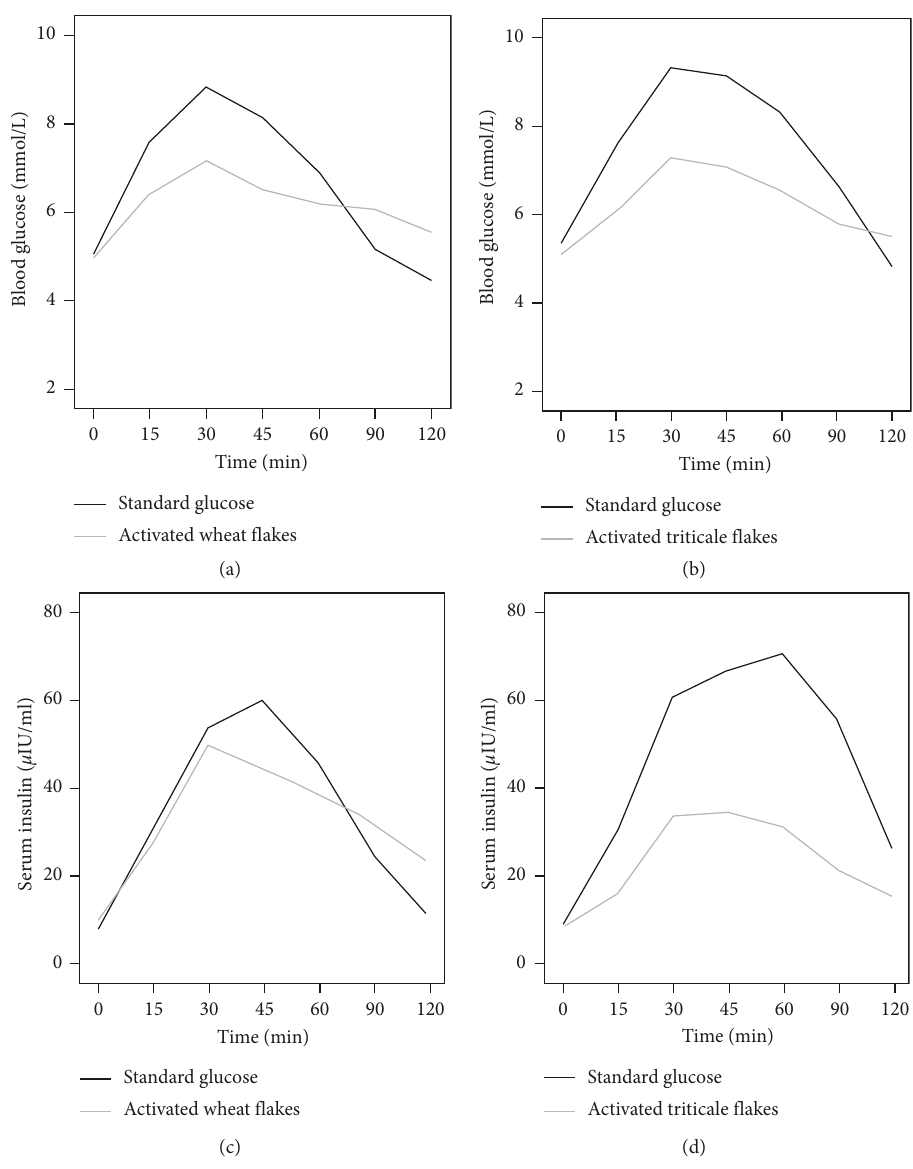
Figure 2: Incremental plasma glucose and serum insulin response ( n � 9). (a) Incremental change in blood glucose in activated wheat flakes. (b) Incremental change in blood glucose in activated triticale flakes. (c) Incremental change in serum insulin in activated wheat flakes. (d) Incremental change in serum insulin in activated triticale flakes. Values are means. In (a), (b), and (d), significant difference between standard glucose and activated flakes was found ( p <